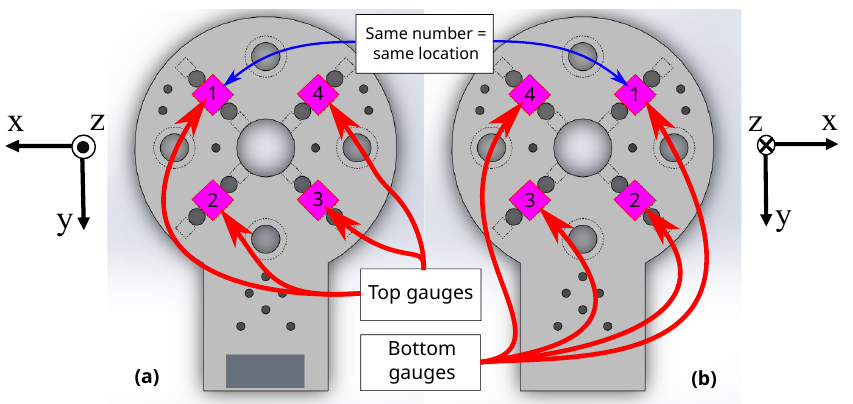
Figure 6. The numerical references of gauge locations 1 to 4 on the ( a ) top surface and ( b ) bottom surface of the sensor. A pair of gauges on top and bottom will share a reference number, but will appear at “mirrored” locations after flipping the body of the sensor. These reference numbers are useful in describing the relationship between Euclidean-space force components and changes in probe voltages between gauge pairs in the voltage divider